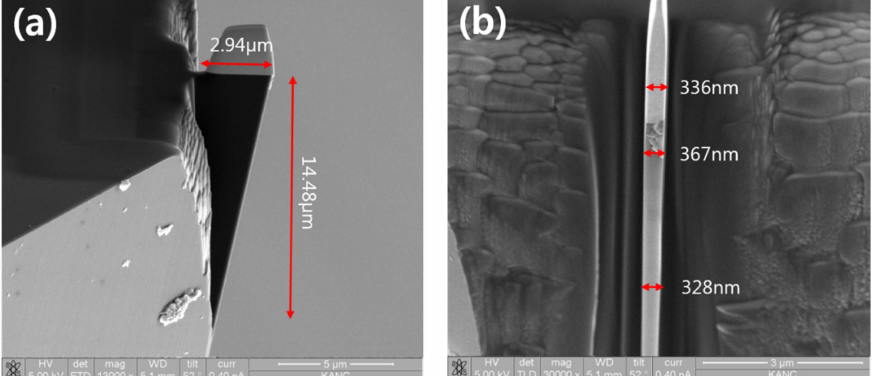
Figure 4. SEM images of 370 nm cutting edge width tool (FIB machined 2.3 µ m Pt coating). ( a ) side view of sample ( b ) front view of